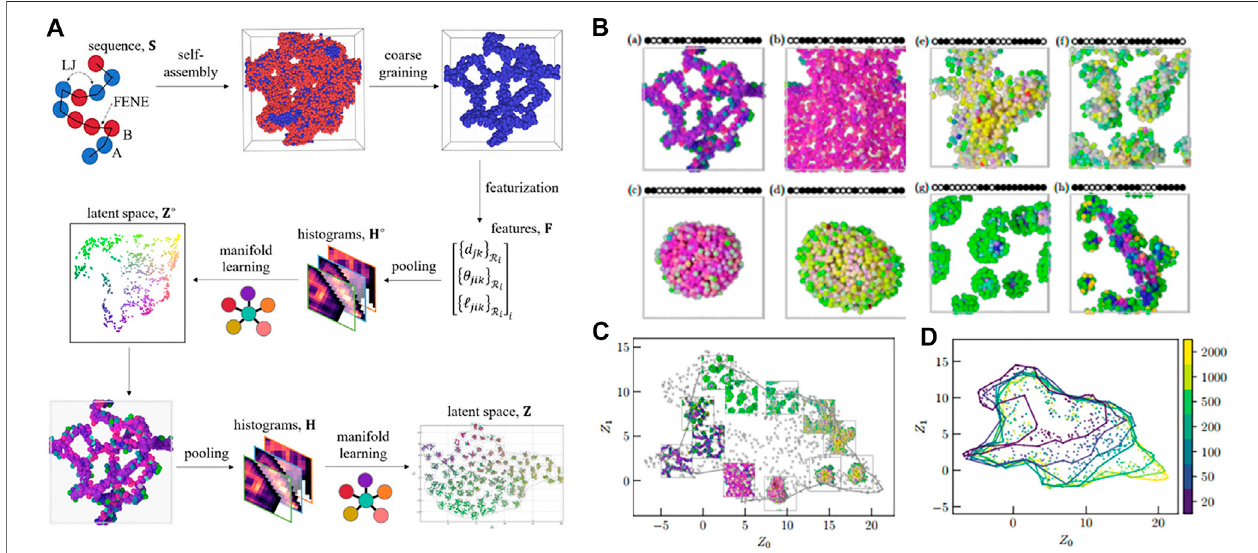
FIGURE 5 | Unsupervised learning of aggregation behavior for a sequence-de fi ned copolymer. (A) Schematic of unsupervised learning method for aggregation classi fi cation: the aggregation con fi guration containing 500 copolymer chains is used as an input, three-body features F i is calculated for each bead which includes distance between neighbors, bond angle, and bond length (featurization) prior to carrying out Gaussian expansion and pooling over the features in order to obtain a histogram H o . The histogram is then embedded into a latent space Z o to obtain local structures of the aggregation, before being implemented in a second pooling and projecting into a latent space Z in which all morphologies can be distinguished. (B) Representative structures perceived from the manifold learning including strings (a) , membranes (b) , vesicles (c) , liquids (d) , structured liquids (e) , disordered micelles (f) , spherical micelles (g) , and wormlike micelles (h) . Sequences are shown (cid:129) schematically, with indicatinganA-beadand ○ foraB-bead. (C) Representativecon fi gurations areembedded in themanifold withnumber ofchains(system size)N (cid:2) 500 showing a fullrange ofpossible structuresfor copolymer ’ s aggregation classi fi cation. (D) The alpha shapes for each system size(N (cid:2) 20, 50, 100, 200, 500, 1,000, and 2,000) in the manifold reveal a gradually larger coverage in the latent space when increasing system size. Figure was reproduced from Ref. (Statt et al., 2021) with permission.